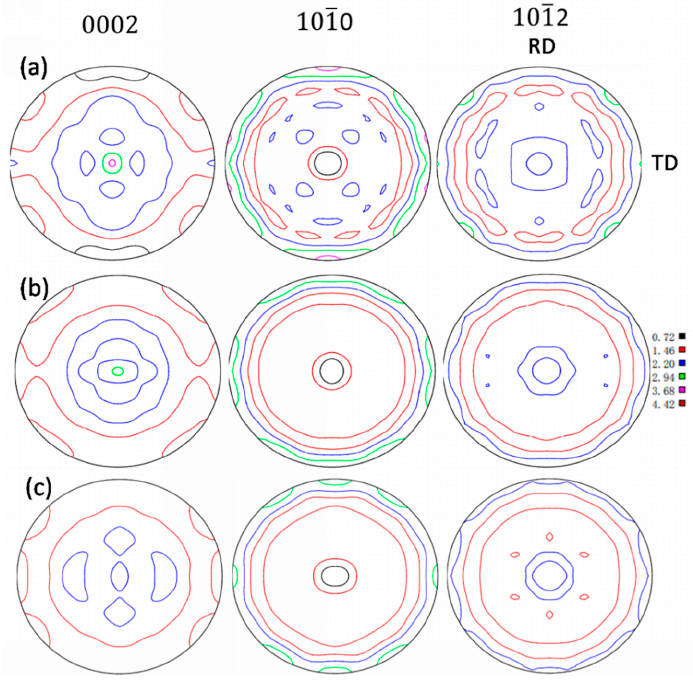
Figure 7. The EBSD results showing the microstructure and texture distribution of the α phase of the as-received alloys: ( a , b ) inverse pole figure (IPF) map from RD and TD direction; ( c ) inverse pole figure (IPF) sheet and ( d ) pole figure (PF).